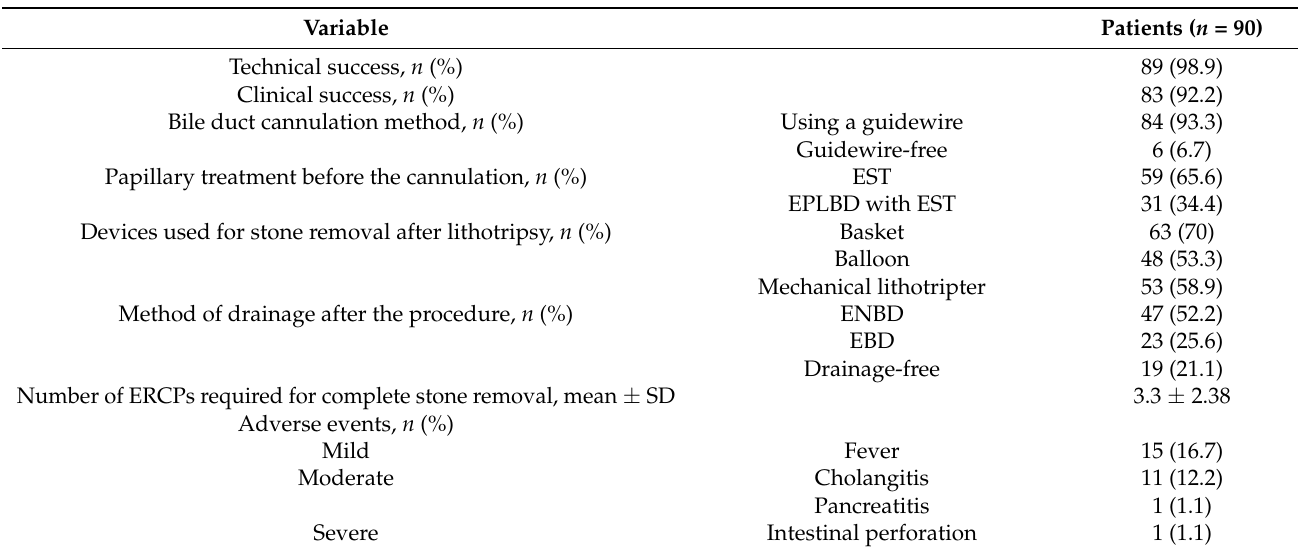
Table 5. Clinical outcomes of therapeutic Spy